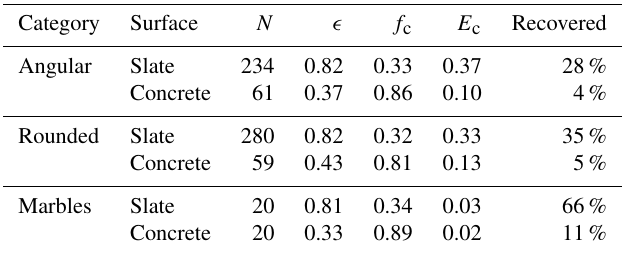
Table 1. Average particle energy partitioning following first collision with a surface as a proportion of initial energy E p0 = mgh . The normal coefficient of restitution (cid:15) was determined using the highest rebound height for each angularity–surface pairing. Calculations of average frictional loss f c and converted translational energy E c are based on pooled data for each particle shape and surface roughness across all recorded